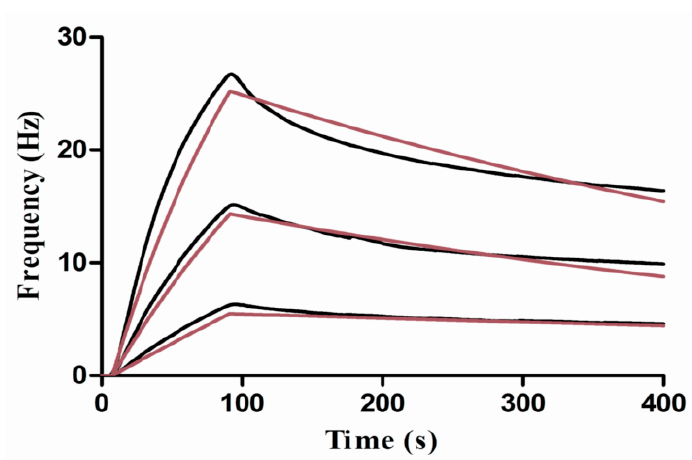
Figure 7. Kinetic evaluation of Con A and mannose interaction. The Con A at 20, 10, 5 μ g/mL was injected over the sensor surface, respectively, and the measured responses were recorded as black lines, the theoretical 1:1 fits using the ClampXP software (Attana) were shown in red lines.